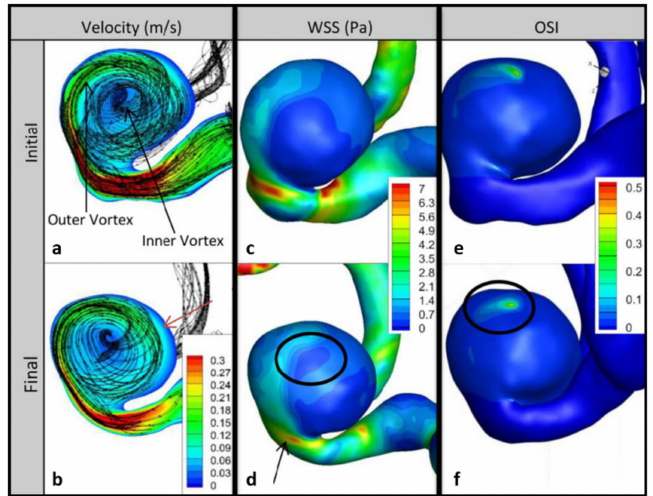
Figure 3. Impingement data planes and wall contours for P1. Velocity column shows changes in velocity between initial ( a ) and follow-up ( b ); red arrow shows region of high velocity gradient where growth occurred. Changes in wall shear stress (WSS) between initial ( c ) and follow-up ( d ); black arrow shows change in WSS near the impingement region and circle shows increase in WSS gradients near low flow. Changes in oscillatory shear index (OSI) between initial ( e ) and follow-up ( f ); circle shows decrease in area of elevated OSI near low flow.